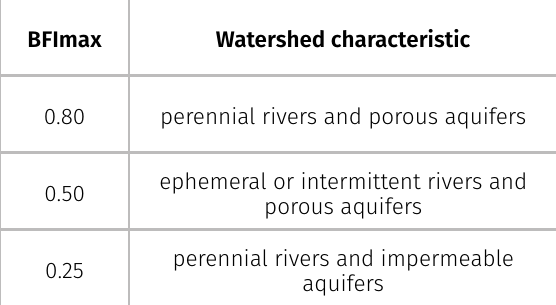
Table II. BFImax values (Collischonn & Tassi 2008). BFImax Watershed characteristic